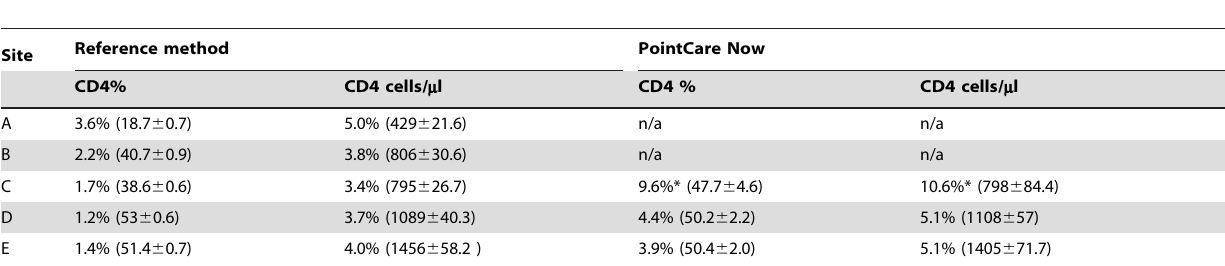
Table 5. Within run precision assessment for absolute CD4 count (cells/ m l) and relative CD4 measurement (%).